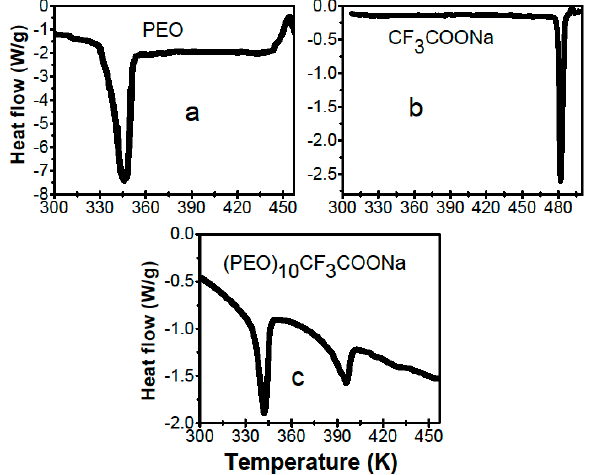
Figure 1. Differential scanning calorimetry (DSC) thermograph for: ( a ) pure poly(ethylene oxide) (PEO); ( b ) pure CF 3 COONa salt and ( c ) (PEO) 10 CF 3 COONa solid electrolyte.